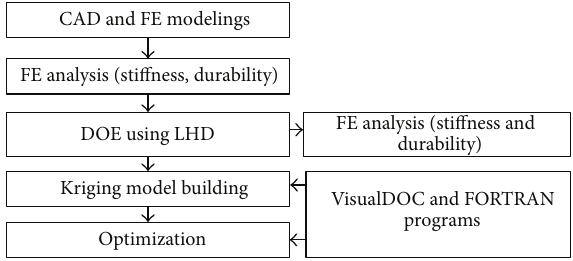
Figure 8: Flowchart of the suggested design